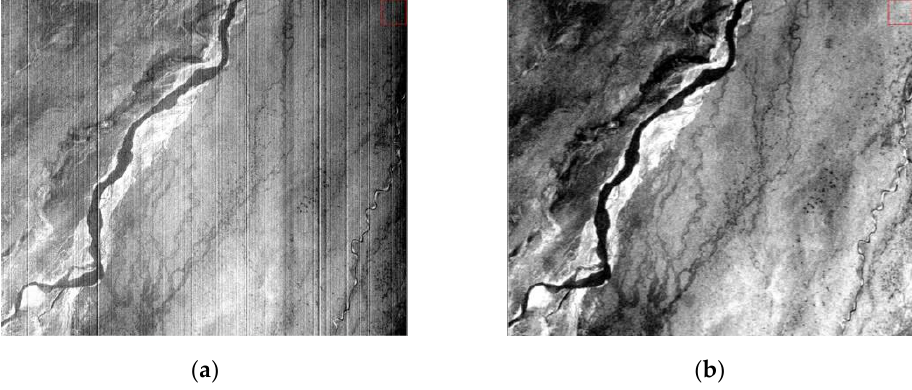
Figure 7. ( a ) Image over a scientific site in China before equalization for the B1 spectral band; ( b ) image over a scientific site in China after equalization for the B1 spectral band.